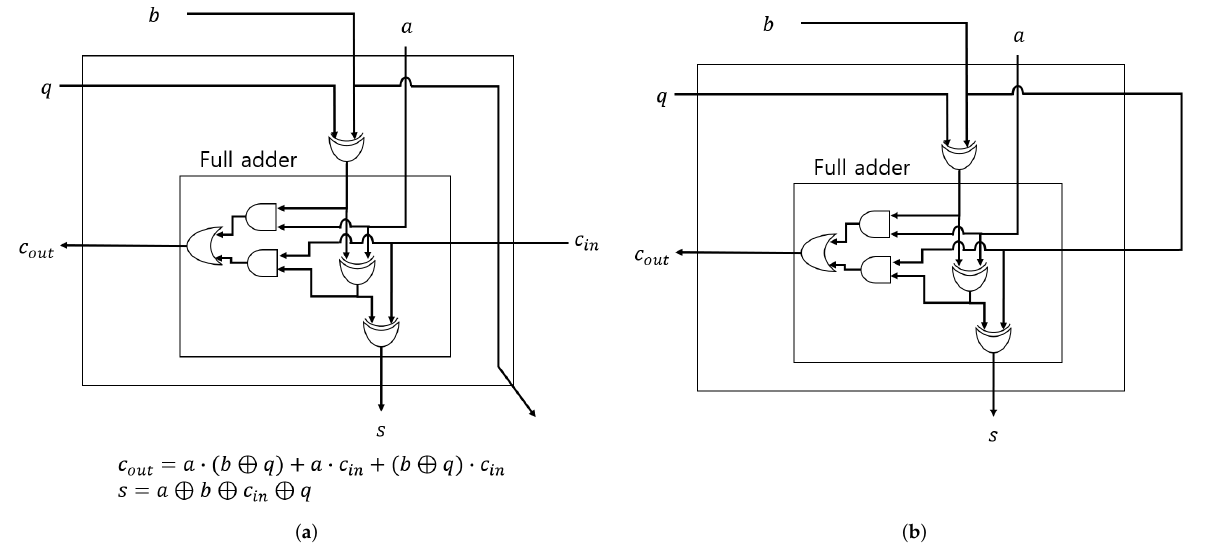
Figure 2. Controlled Add–Subtract (CAS) cells used in a square root array circuit: ( a ) a cell in the middle portion of the array, ( b ) a cell in the rightmost position of each